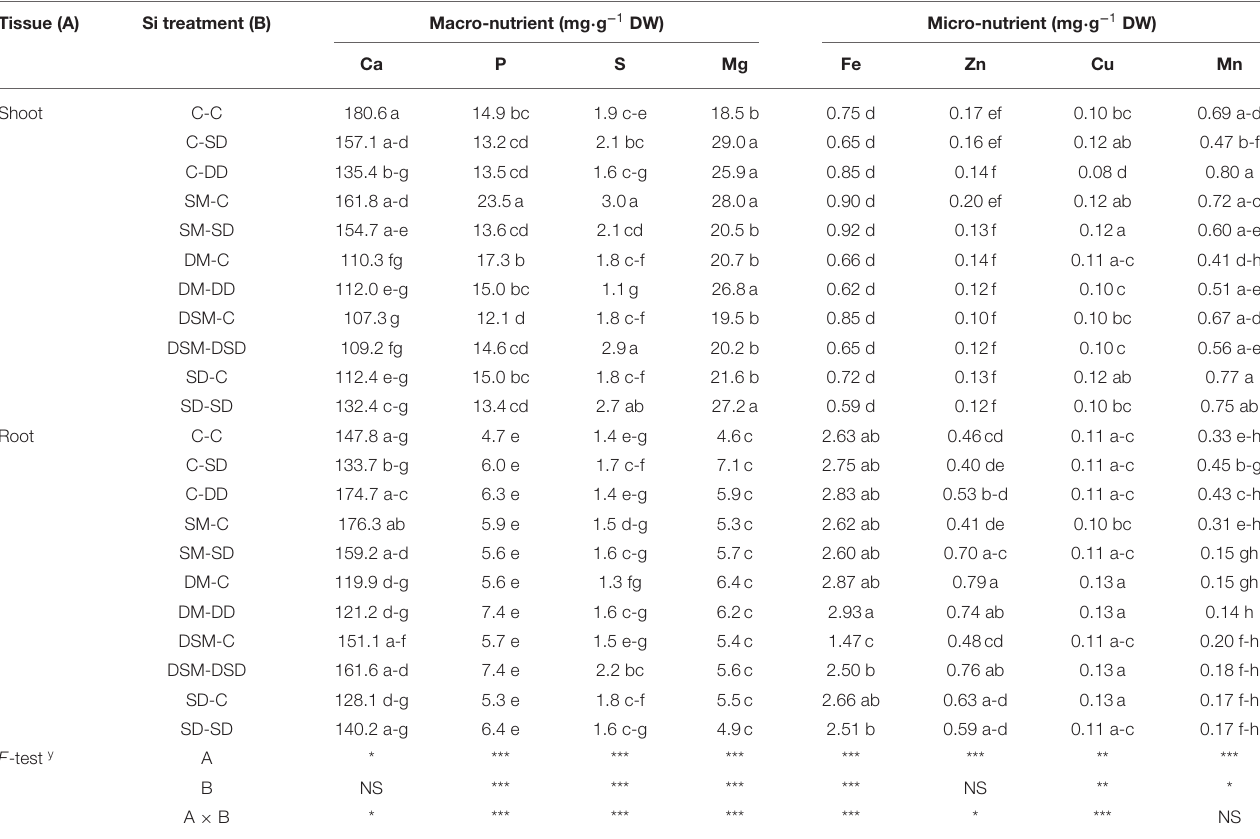
TABLE 3 | Mineral contents in leaves and root of “Sulhyang” transplants as affected by different Si treatments. Tissue (A) Si treatment